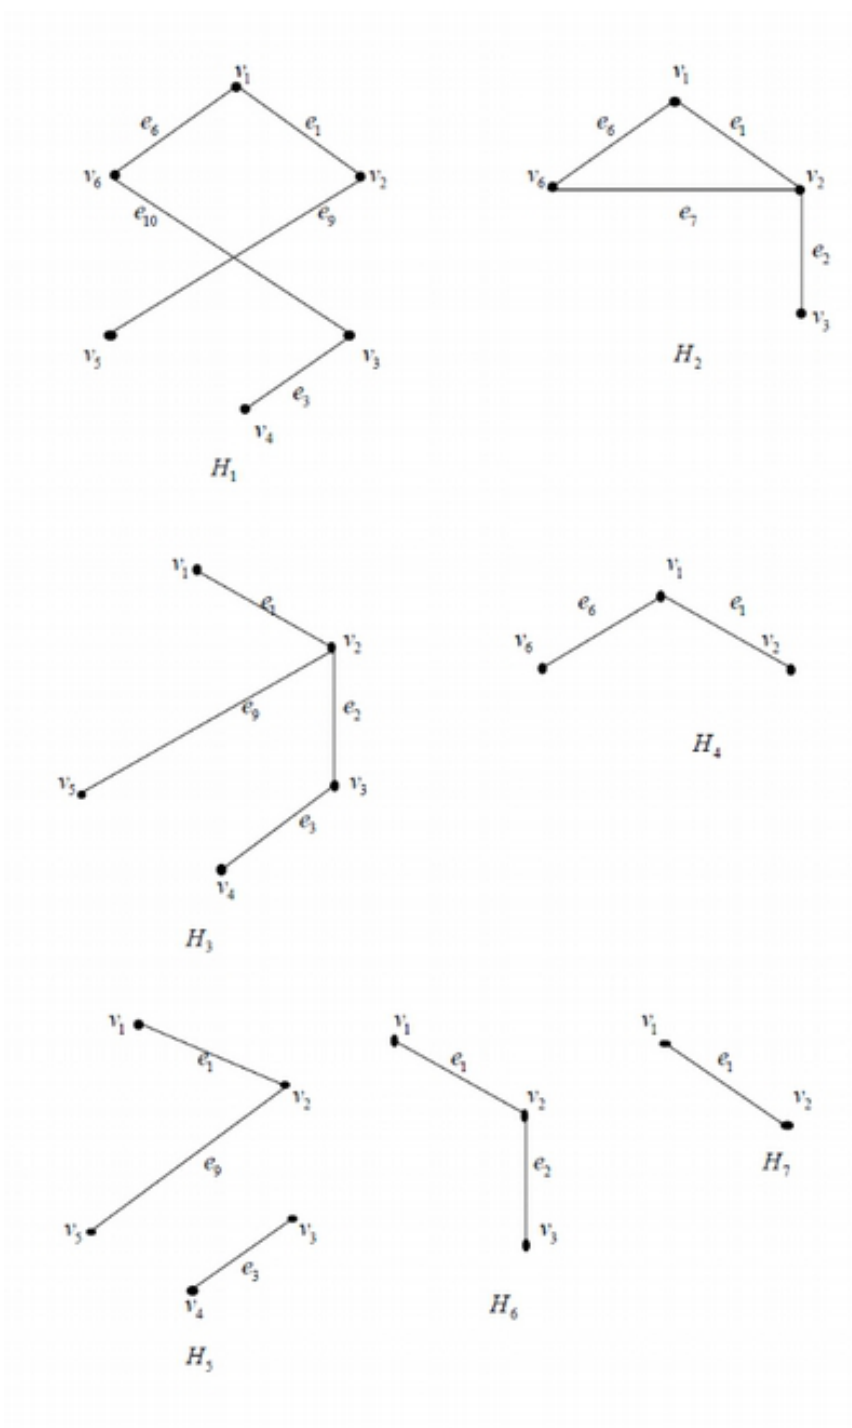
Figure 2: Subgraphs of the graph